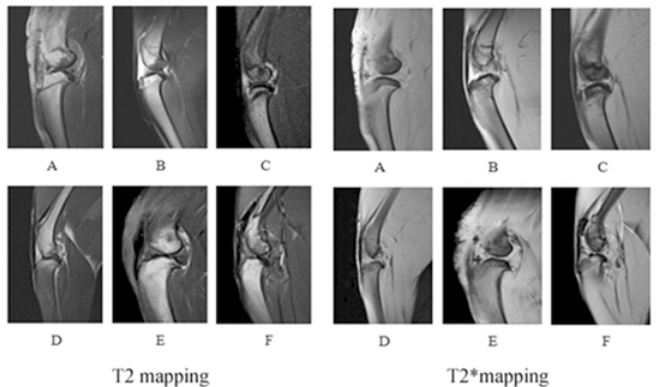
Fig 7. T2 mapping images (A-F) and T2 * mapping (A-F) images of rabbit cartilage at different time points after surgery (W2, W4, W8, W12, W16, and W20). The cartilage was integral and had moderate to slightly high linear homogeneous signal (A-B). The cartilage had moderate to slightly high signal and poor contrast with adjacent synovial fluid, adipose tissue and myeloid tissue(C-D). The cartilage was not integral and had slightly high heterogeneous